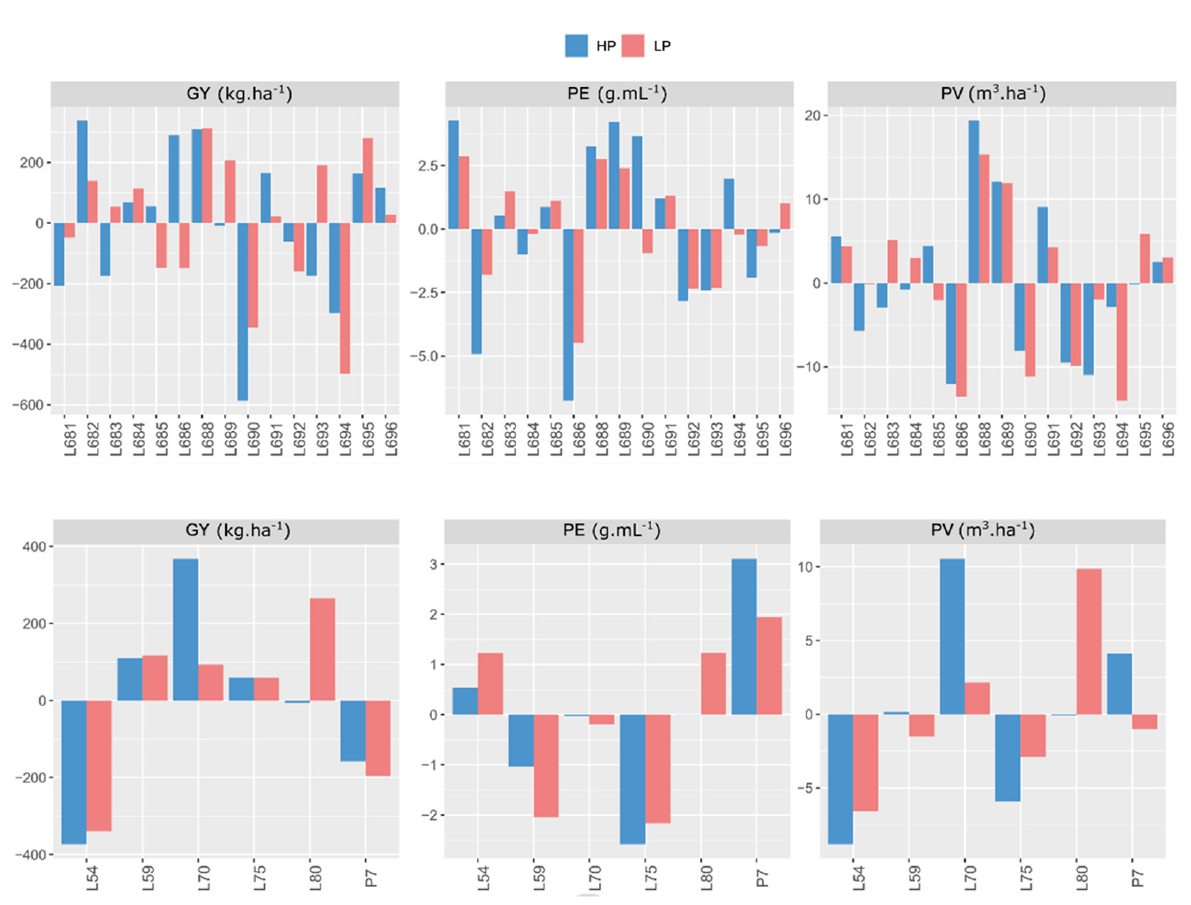
Figure 1. Estimates of general combining ability effects ( ĝ i ) for three traits evaluated in 21 popcorn parents in a partial diallel scheme in Campos dos Goytacazes. HP—high phosphorus level; LP—low phosphorus level; PE—popping expansion; GY—grain yield; and PV—popcorn expanded volume per hectare; (-) signal indicating negative values.